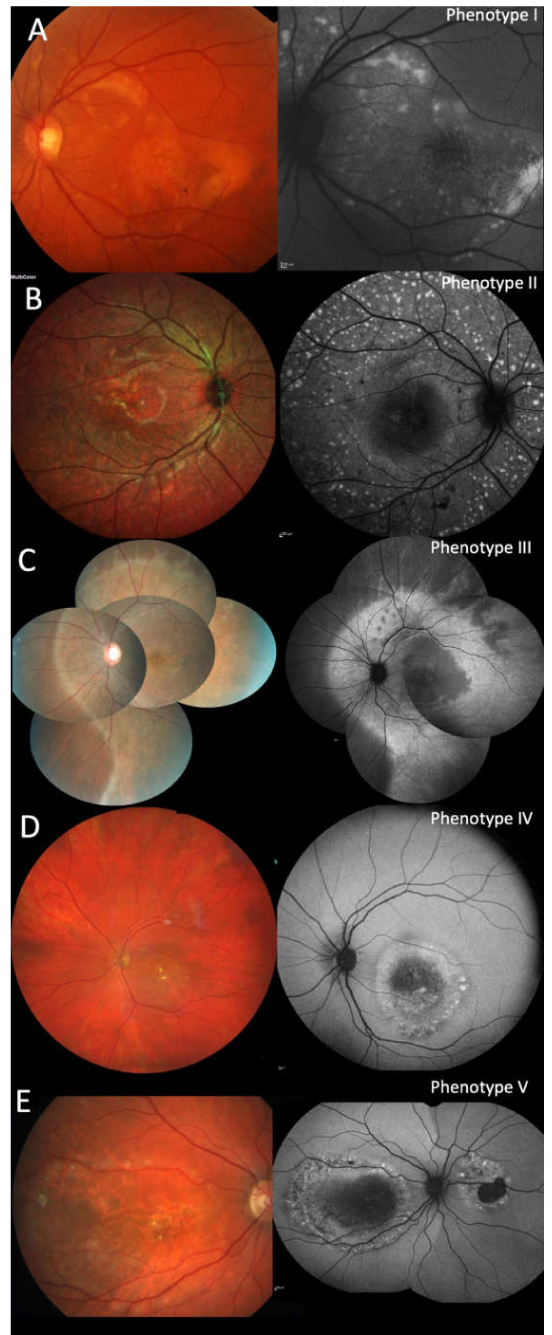
Figure 1. Autosomal recessive bestrophinopathy phenotypes I-V: Fundus photography and fundus autofluorescence (FAF): ( A ). (#5) multiple fleck-like and often confluent yellow lesions involving the posterior pole and extending to the mid-periphery beyond the vascular arcades and nasal of the disc. ( B ) (#8) multiple small fleck-like, mostly non-confluent yellow lesions involving the posterior pole and extending to the far periphery. ( C ) (#15) a continuous yellowish area without flecks extended partly into the far periphery and was bordered by a sharp demarcation line. ( D ) (#11) one Best vitelliform macular dystrophy (BVMD)-like lesion at the posterior pole resembling unifocal BVMD. ( E ) (#18) two well-circumscribed lesions consistent with multifocal